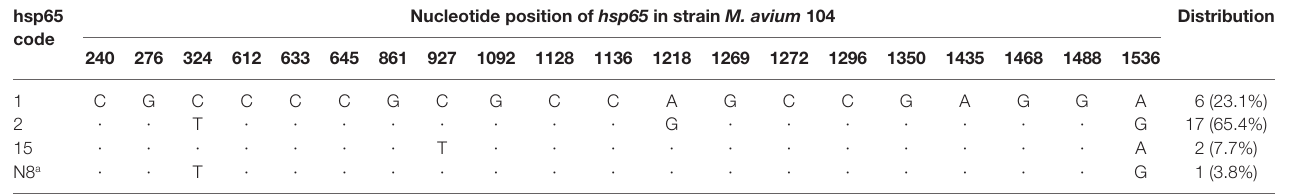
nucleotide position of hsp65 in strain M. avium